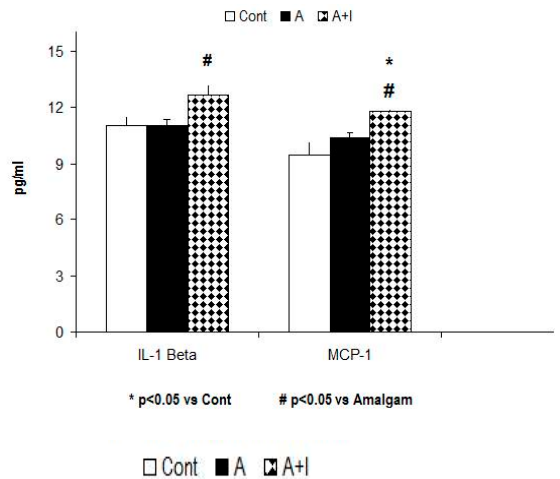
Figure 5. Increased IL-4 and MCP-1 levels in patients with long-term titanium dental implants and